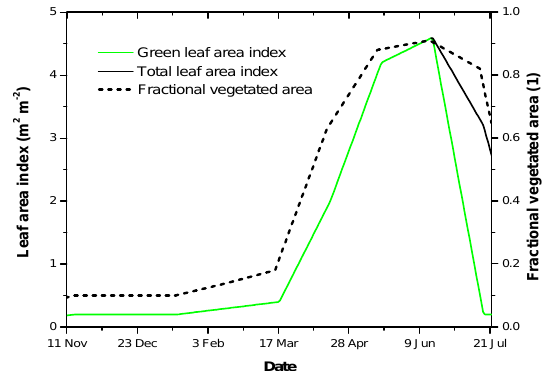
Figure 3. Effect of the energy balance ratio threshold τ on the en- ergy balance closure and the fraction of data points remaining in the data set for model